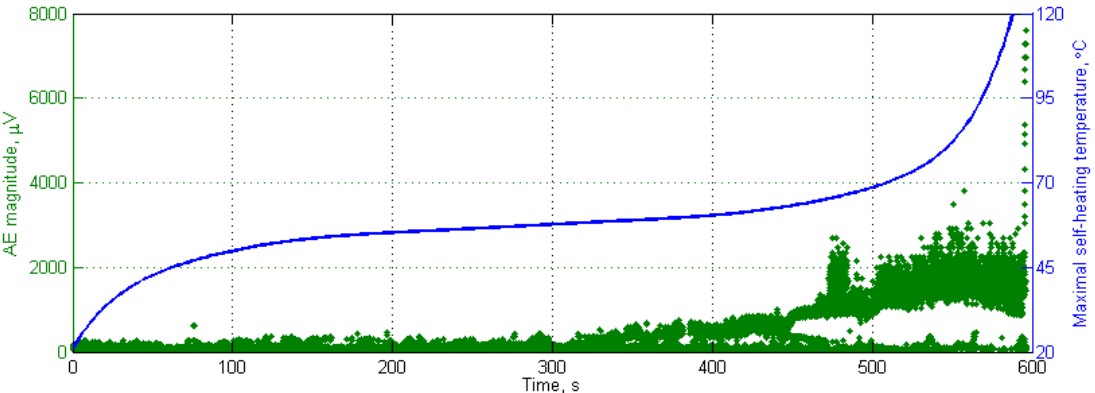
Figure 7. Representative acoustic emission (AE) response with the self-heating temperature history curve.